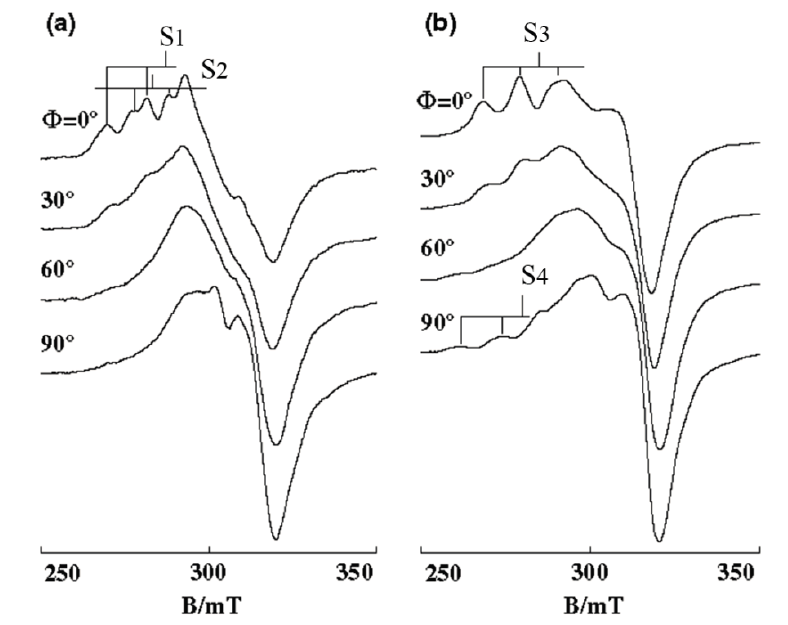
Figure 10. EPR spectra of 5 on B-form DNA-fibers at ( a ) room temperature and ( b ) − 150 °C [28]. S3 is the overlapped g || signal of S 1 and S 2